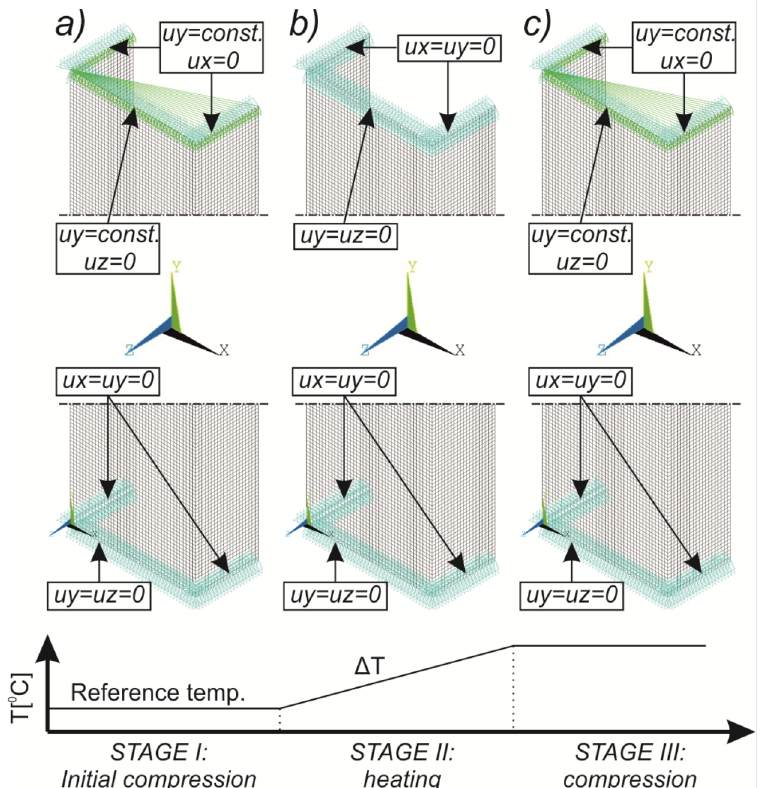
Figure 5. Discrete model of considered columns with the assumed boundary conditions divided into three stages: initial compression ( a ), heating ( b ) and final compression to global failure ( c ).